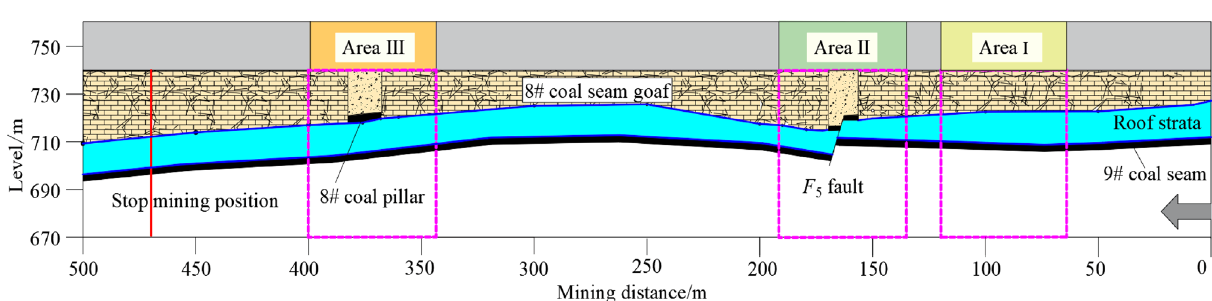
Figure 3. Geological section of the test area.